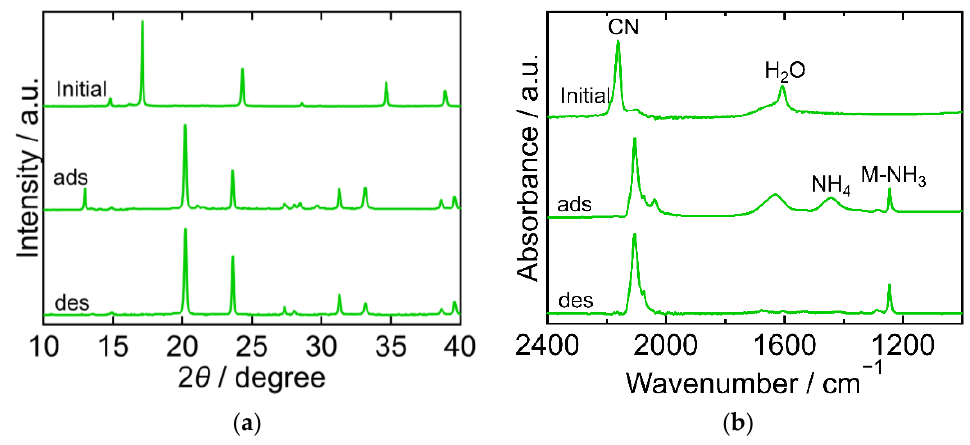
Figure 5. XRD patterns ( a ) and FTIR spectra ( b ) of zinc hexacyanoferrate (ZnHCF). “Initial” sample is literally the sample before adsorption. The samples after adsorption and desorption are denoted by “ads” and “des”, respectively. The measurements were performed at ambient temperature.